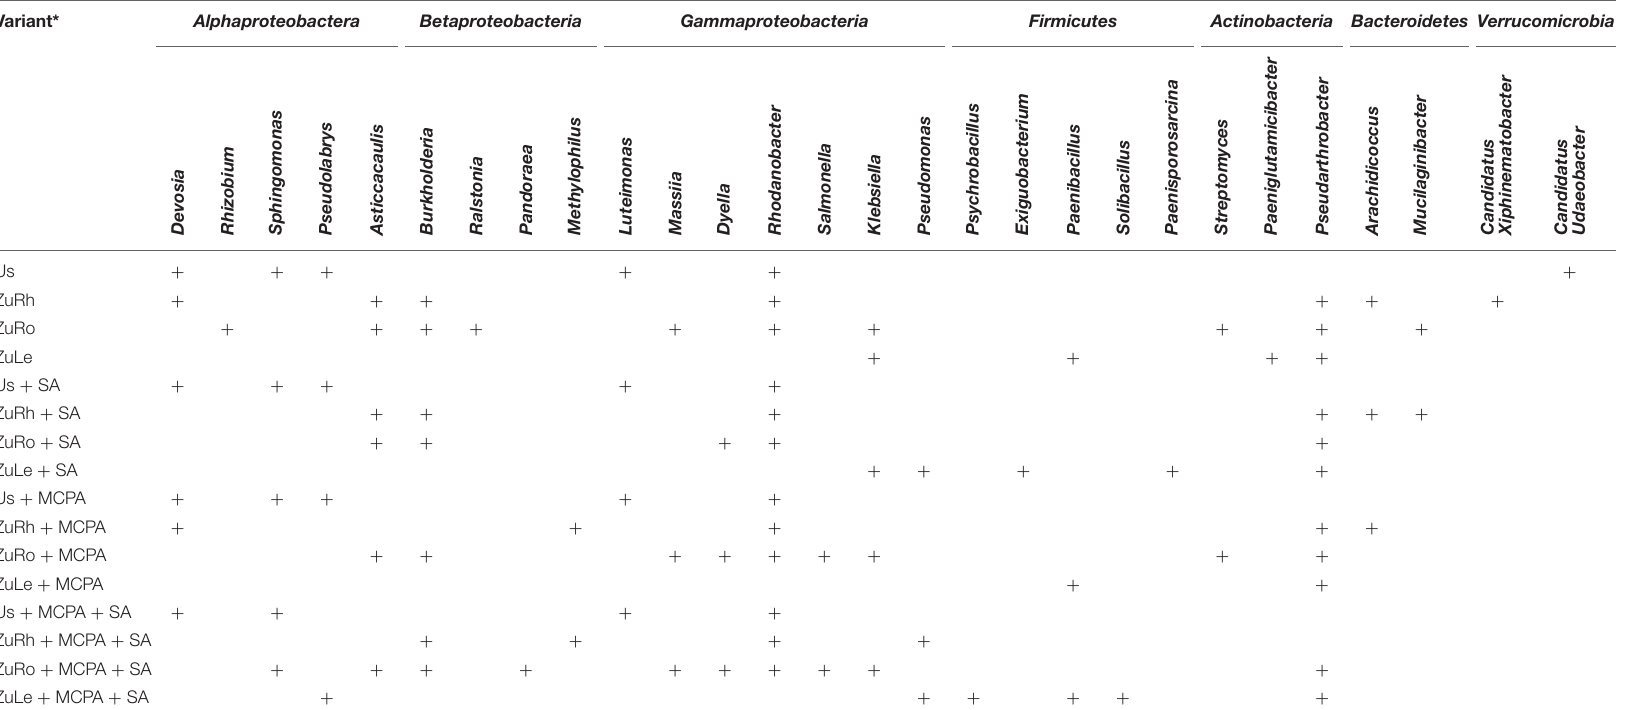
TABLE 4 | Presence ( + ) of bacterial genera with relative abundance > 1% in the different variants.